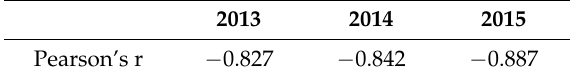
Table 2. Correlation parameters between ln(Fe) and pH for each year.